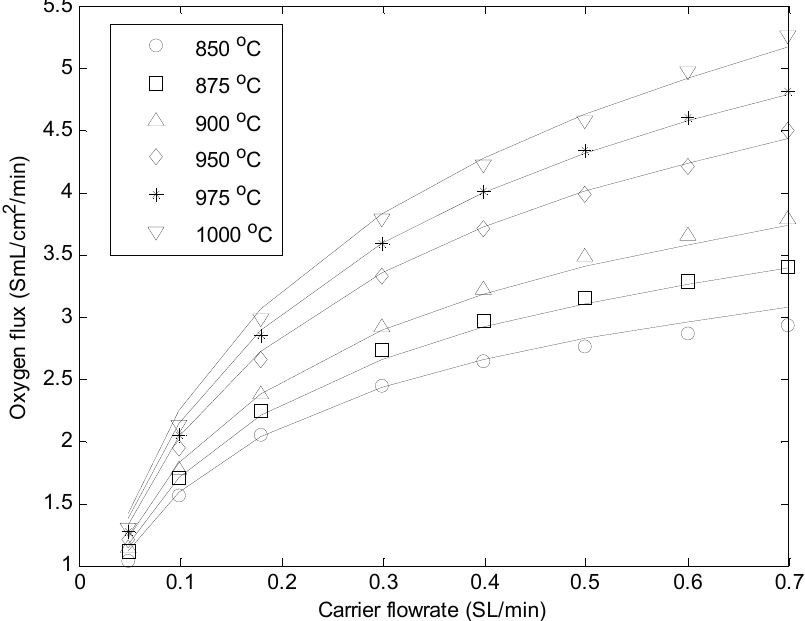
Figure 3. Comparison between experimental (symbols) and calculated (continuous lines) oxygen fluxes using BSCF membrane at different temperatures and carrier flow